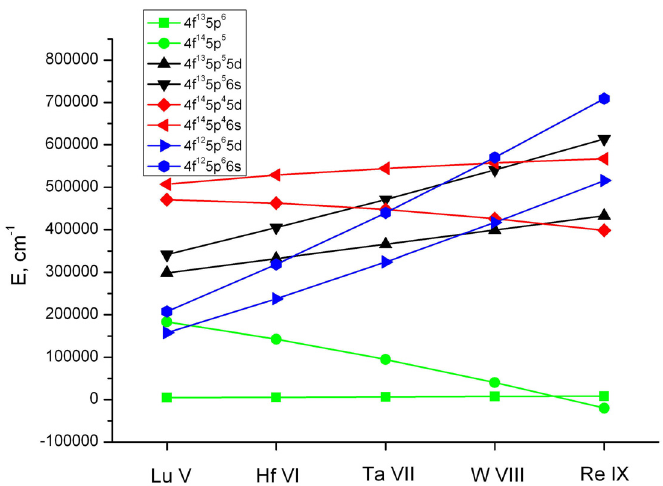
Figure 1. Calculated average energies of the low-lying configurations in the W VIII isoelectronic